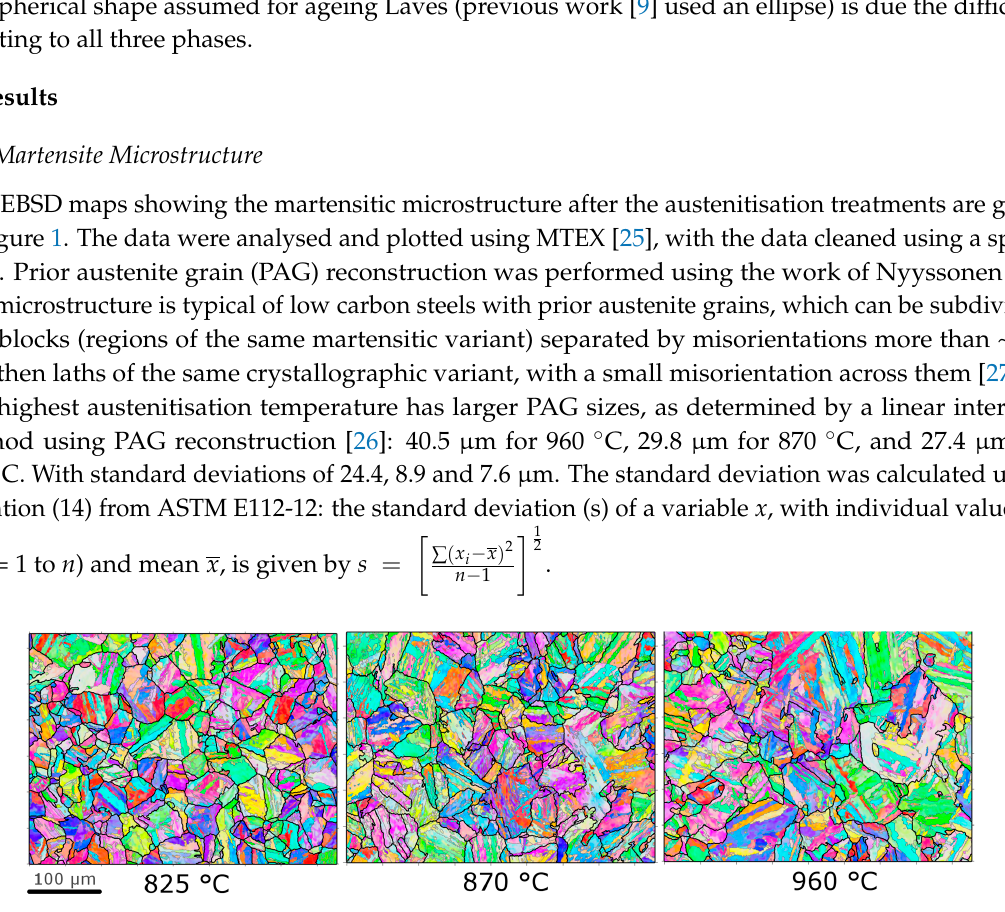
Figure 1. EBSD (Electron back-scattered diffraction) maps of the martensitic microstructure after different austenitisation conditions prior to ageing. Black lines indicate PAG (Prior austenite grain) reconstructions (using [26]) and grey lines are boundaries with misorientation greater than 5°.